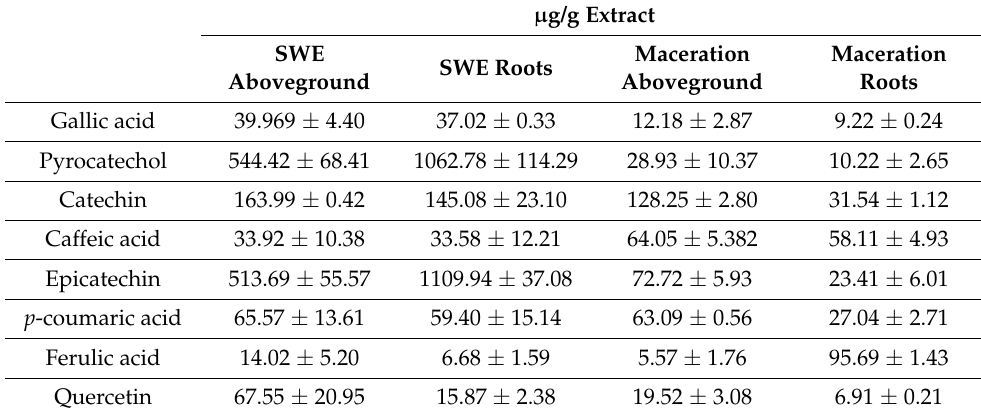
Table 6. Quantification of O. mutabilis